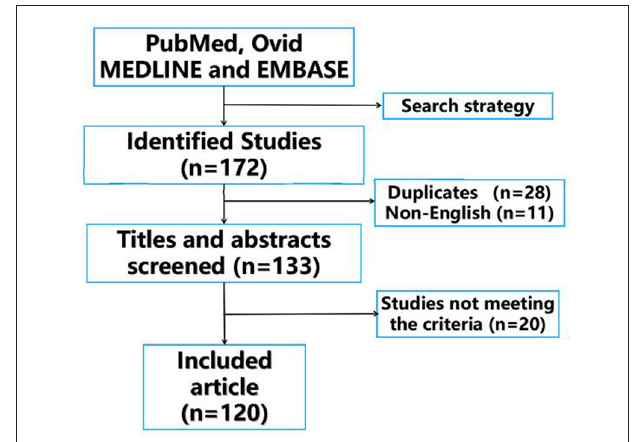
FIGURE 1 | Flowchart of the identification, evaluation, and inclusion of studies in the review.